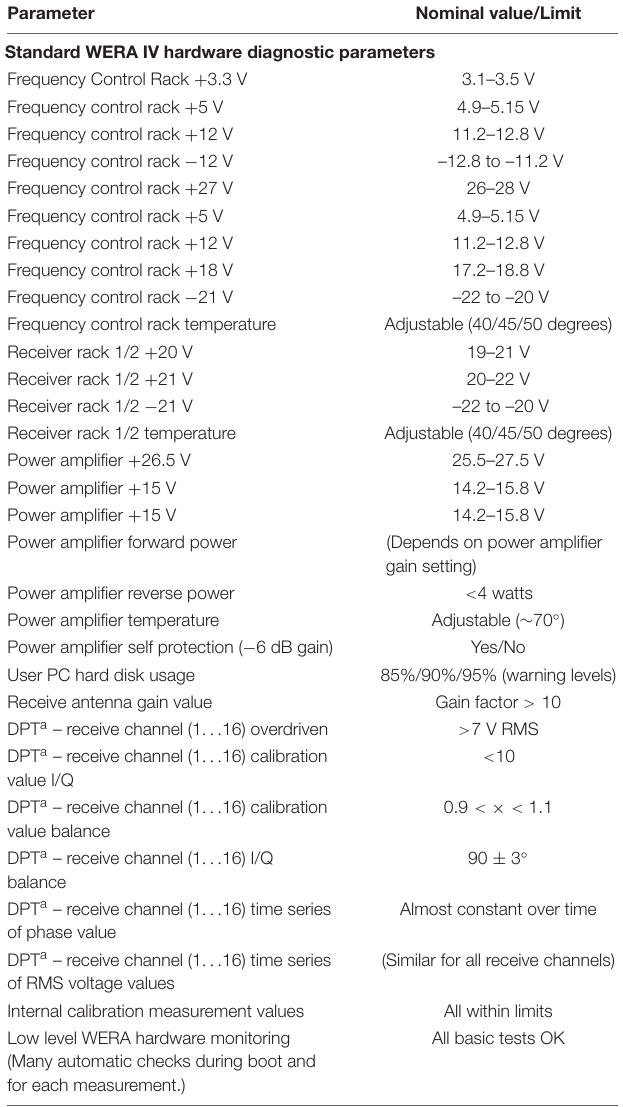
TABLE 6 | Recommended ranges for diagnostic parameters for WERA HFR systems as reported by the manufacturer